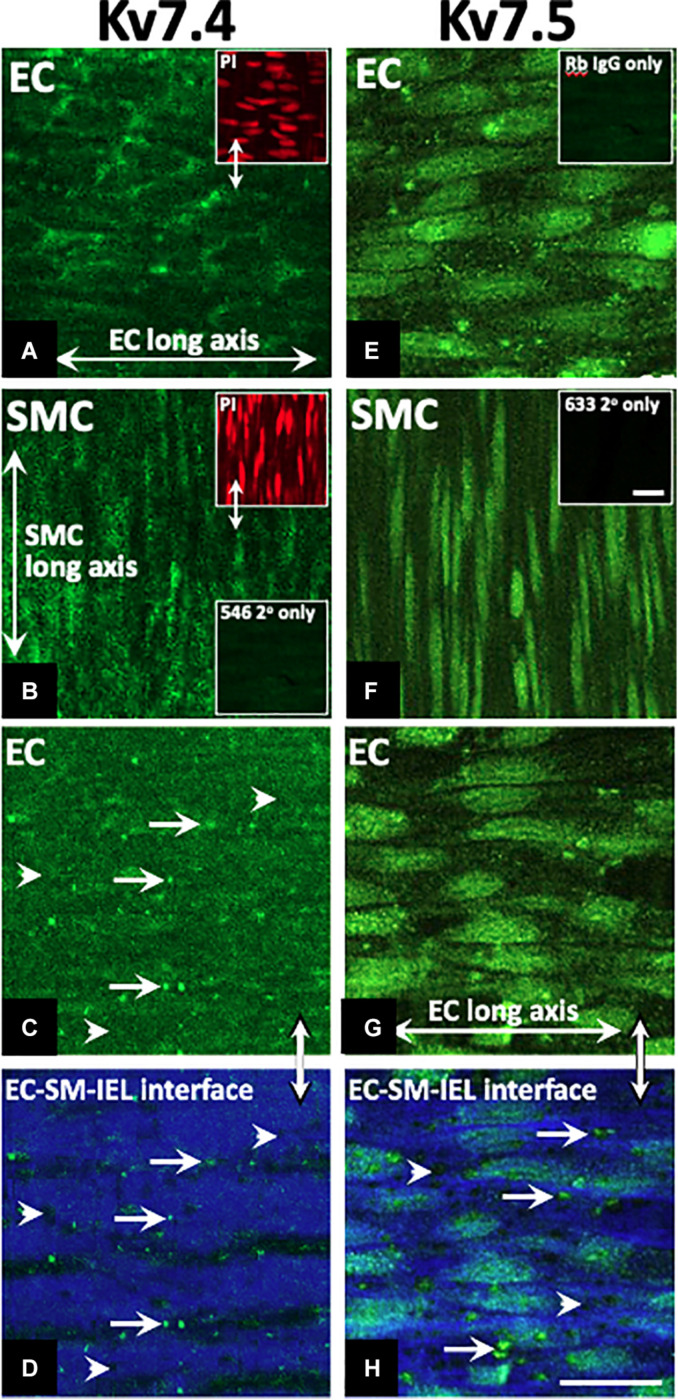
Immunohistochemistry demonstrates Kv7.4 and 7.5 localization in rat mesenteric artery endothelium (EC) and smooth muscle cells (SMCs) with a focus on internal elastic lamina (IEL) hole sites in whole mount tissue. Whole mounts of confocal stacks through the EC and SMC of Kv7.4 (A,B, respectively) and Kv7.5 (E,F, respectively). Confocal image stacks through the luminal EC to SM border (C,G) show diffuse/punctate Kv7.4/KV7.5 across the cell membrane with some punctate higher-level fluorescence at localized sites (e.g. full arrows; C). When single images were taken at the EC-IEL-SM interface (D,H), punctate higher-level fluorescence densities were present (e.g. D,H arrows; H, higher magnification inset) at a proportion of IEL hole sites (e.g., D,H arrowheads). Propidium iodide (PI; e.g., upper left inset, A,B) were used as nuclear markers to verify cell and layer patency. Incubation in secondary only separately for each of the 3 fluorophores (Table 2; e.g. lower left inset, B; inset, F) were used to set ‘zero’ confocal settings. Incubation in isotype IgG control only (e.g., E, inset) showed fluorescence equivalent to secondary alone (e.g., B, lower inset; F, inset). n = 4, representative of different source. Longitudinal vessel axis, left to right. Double arrows indicate same site, but at different focal planes (C,D,G,H), and location of inset (D). Bar, 25 μm.